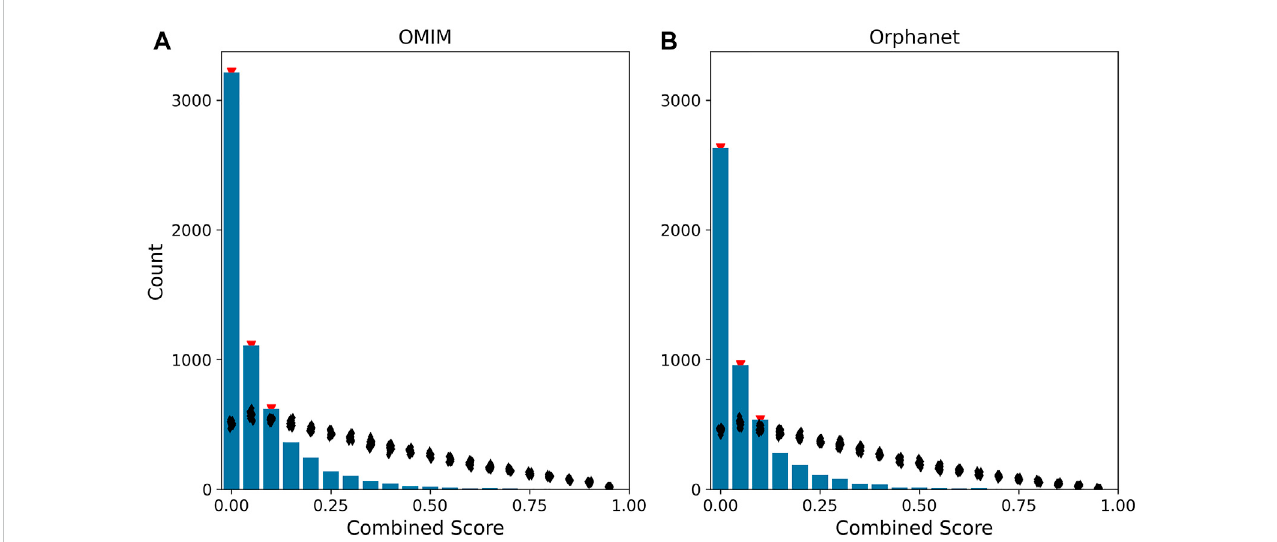
FIGURE 4 Distribution of disease scores. The histograms represent the distribution of disease scores for gene-disease associations in OMIM (A) and Orphanet (B) . The combined score of a gene is de fi ned as the geometric mean of the rank-transformed scores of the gene for all phenotypes associated to the disease. In the fi gure, combined score values are binned into 20 intervals ( x -axis). The black dots indicate the distribution of the combined score obtained after 100 randomizations of the gene-disease associations. Redtriangles mark the bins having acount higher than the one obtained after randomization with p <